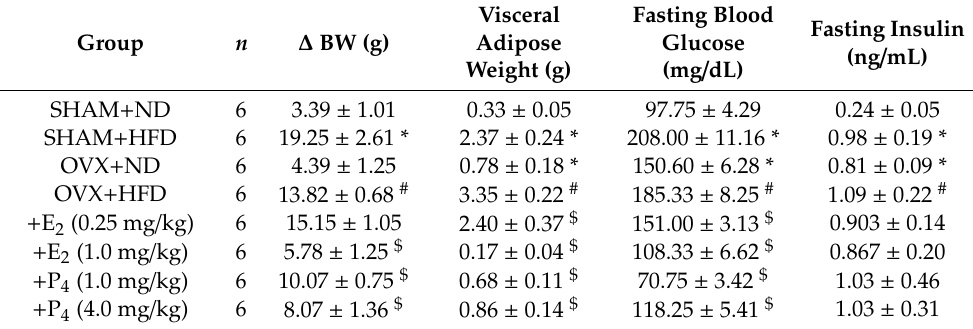
Table 1. E ff ect of E 2 and P 4 on animal body and visceral adipose weights, fasting glucose, and insulin levels. Group n ∆ BW (g)